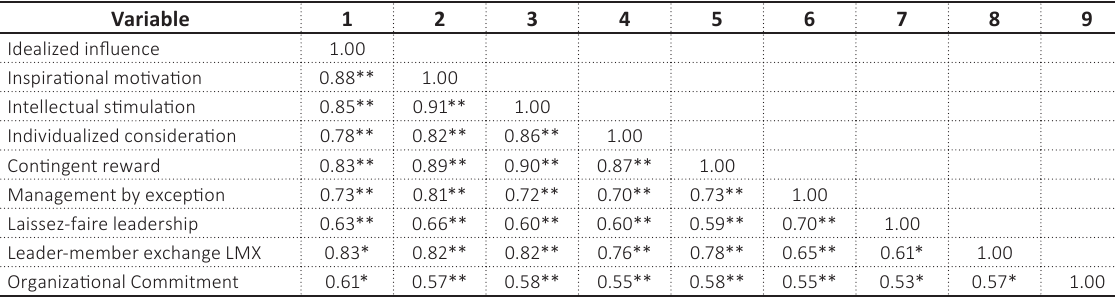
Table 3. Inter-correlations between study variables